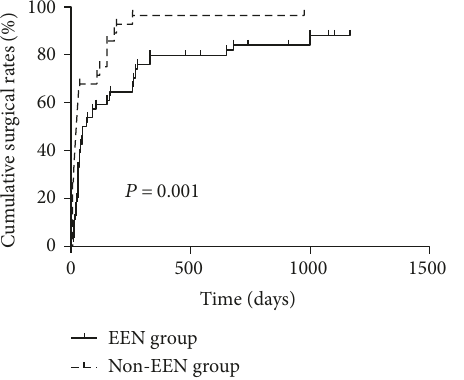
Figure 1: The cumulative surgical rate was signi fi cantly lower in the EEN group than in the non-EEN group ( P = 0 001